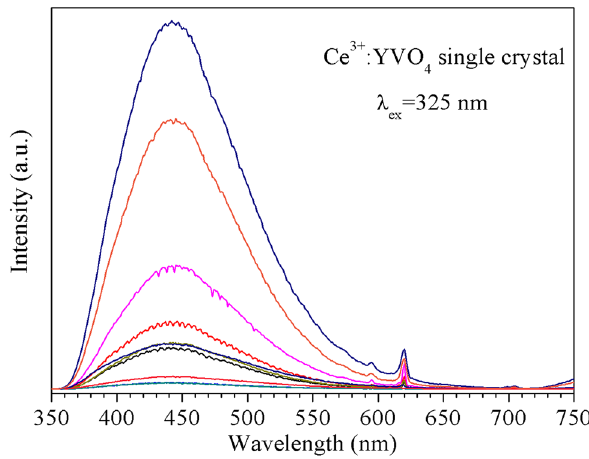
Figure 5: Emission spectra of Ce 3 + - doped YVO 4 crystals with dif - ferent cerium doping concentrations. The excitation wavelength is 325 nm corresponding to the 1 A 1 → 1 T 2 absorption transition of VO 43−